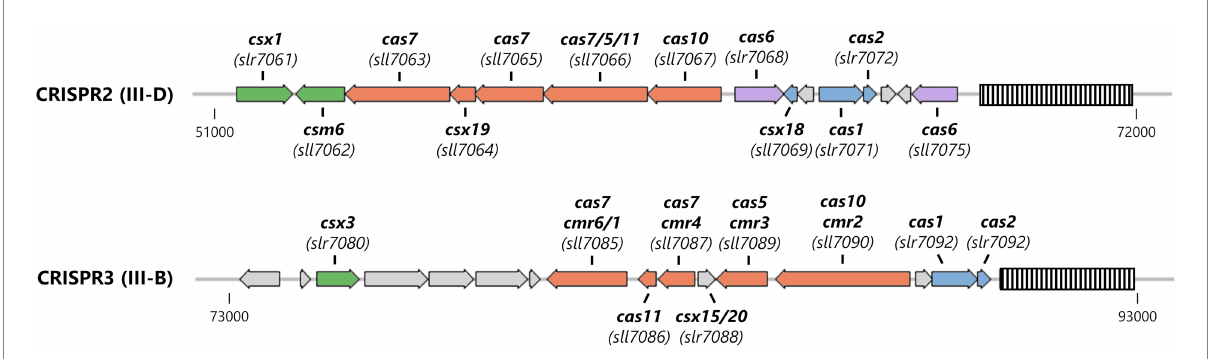
FIGURE 1 Organization of the Type III CRISPR-Cas systems encoded on the large plasmid pSYSA in Synechocystis . The CRISPR arrays are shown as striped boxes. Genes are color-coded: adaptation-associated genes (blue), effector complex components (salmon), pre-crRNA processing (purple), and ancillary genes putatively involved in cOA-signaling